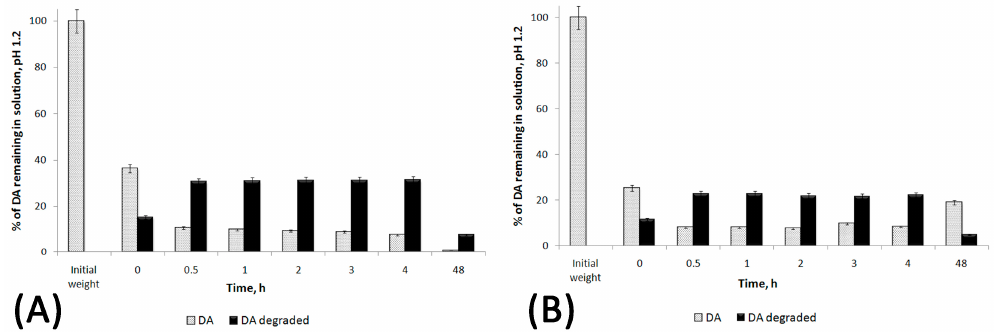
Figure 11. The percentage of DA remaining in water solutions of dissolved DA ( A ) and the DA: β CD (1:1) inclusion complex ( B ) at pH 1.2 and at different time intervals, using HPLC to analyze.